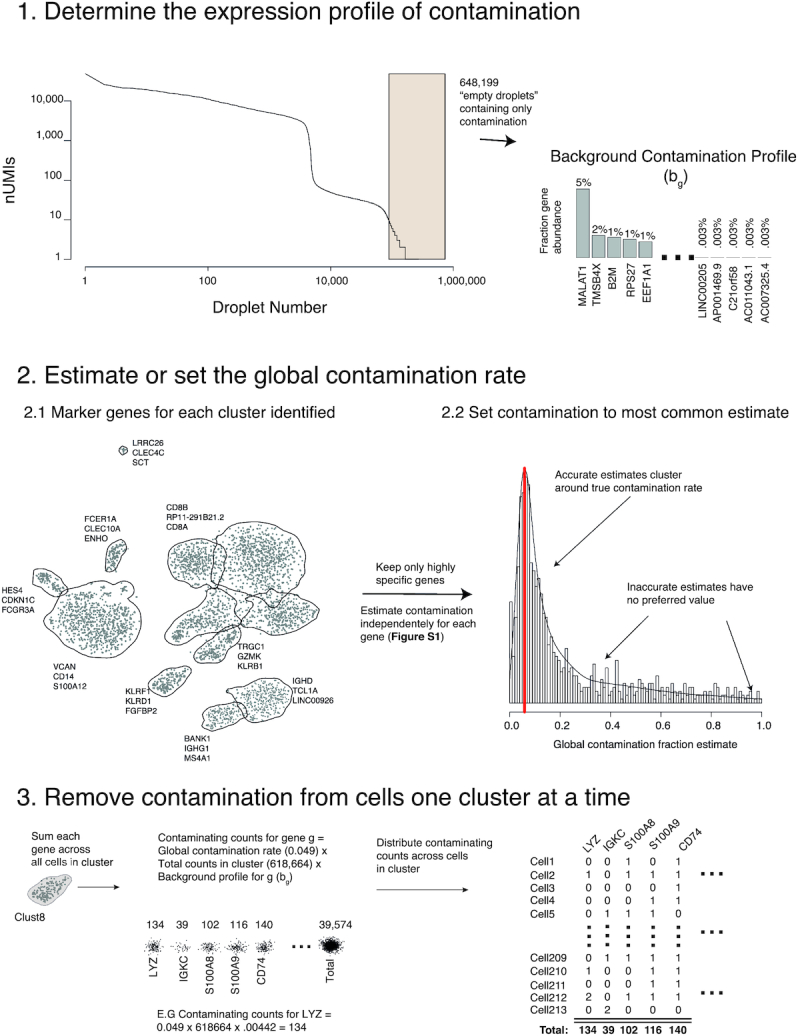
A visual summary of the SoupX method, using data from the PBMC dataset.